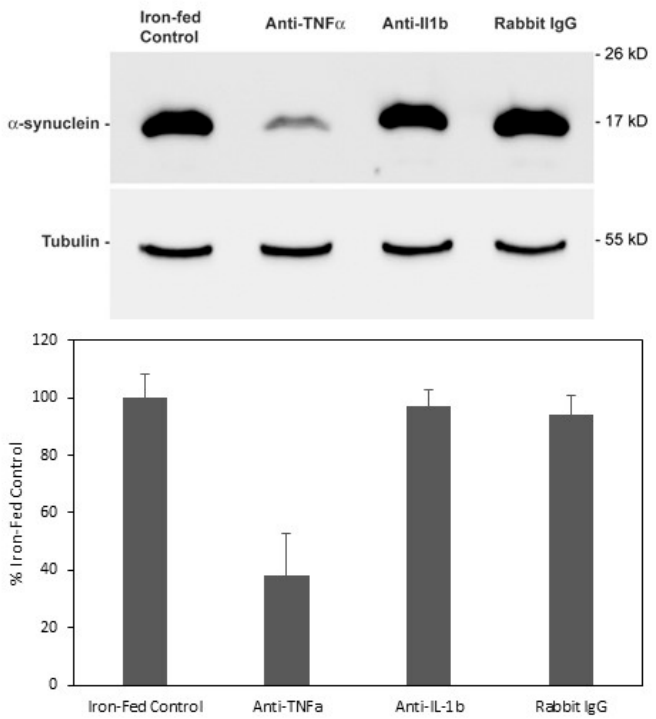
Figure 8. Cytokine Neutralization SH-SY5Y. Cells were treated with conditioned medium from iron-fed C8B4 microglia pre-treated with antibodies in an attempt to neutralize cytokines present that may be responsible for inducing increased expression of α -syn. We tested the effect of antibodies to TNF α , IL-1 β and as a control, rabbit IgG. Medium was treated with 150 ng/mL of the specific antibody for one hour before applying to the SH-SY5Y cells. After 24 h western blot was used to assess the level of α -syn protein and tubulin to compare loading. On the antibodies tested only anti- TNF α caused a significant ( p < 0.05) reduction in the level of α -syn detected. Shown are the mean and S.E.M. of four separate